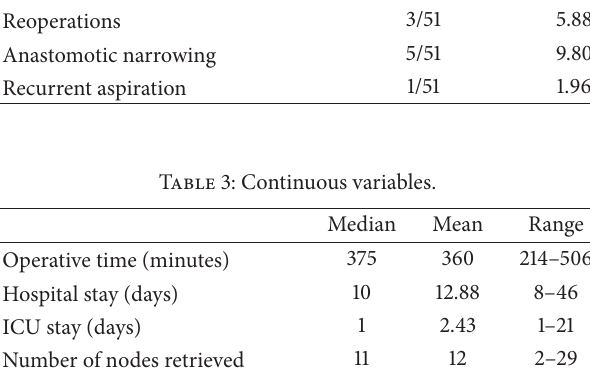
Figure 1: Overall survival.